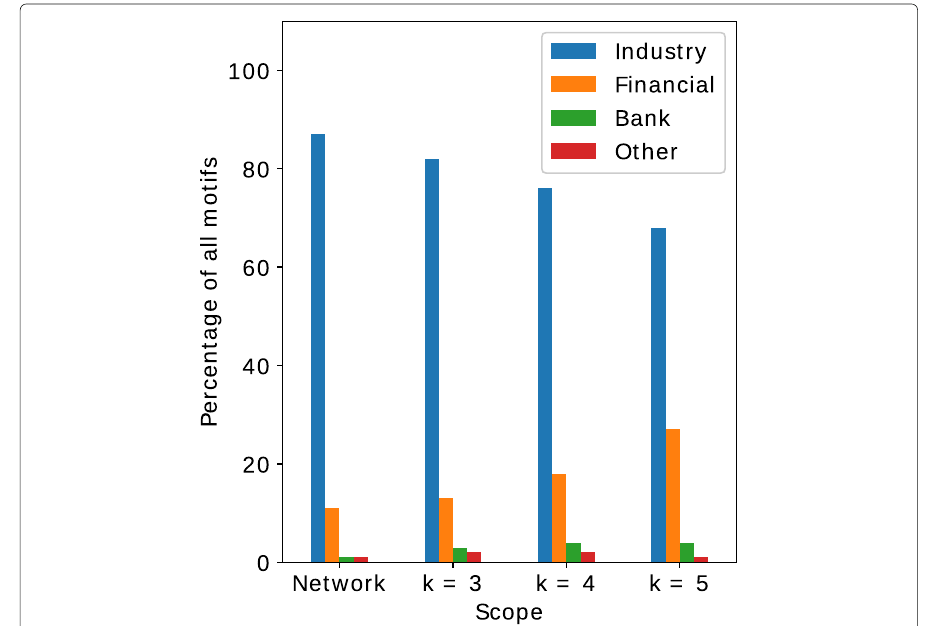
Fig. 9 Division of firms over economic sectors, for the full network (leftmost set of bars) and motifs of different sizes (three rightmost sets of